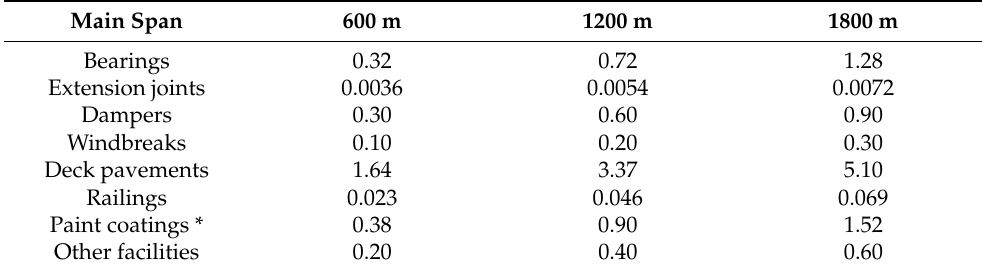
Table 7. The material cost of auxiliary facilities (unit: USD 10 6 ).